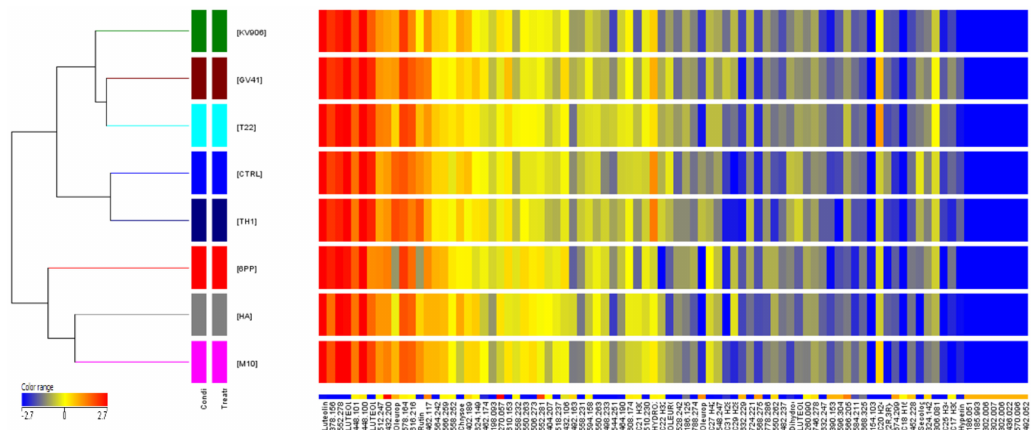
Figure 4. Hierarchical clustering heat map of di ff erential metabolic profiles from olive leaf extracts. Samples are indicated according to the treatments with Trichoderma strains (M10, KV906, GV41, TH1, and T22) or secondary metabolites (6PP and HA). Plants treated with water (CTRL) were used as controls. Red and blue colors indicate, respectively, a relatively higher and lower chemical abundance. Yellow indicates a neutral change from the overall average abundance found across all samples. Each column represents one metabolite, with rows on the left having an overall higher level of perturbation across the metabolomes. The heat map was developed by using Agilent MassProfiler Professional bioinformatics software and statistical di ff erences were determined through ANOVA statistical testing (one-way ANOVA, p <